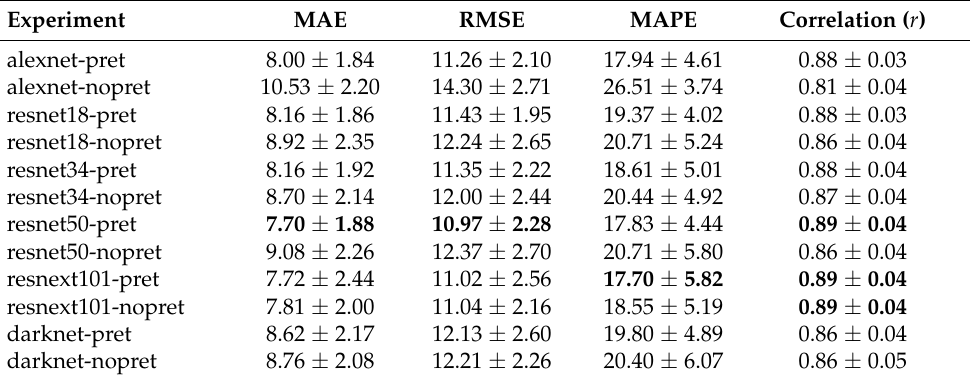
Table 4. Mean and standard deviation for each model setup of the 10-fold cross-validation. Best results presented in bold